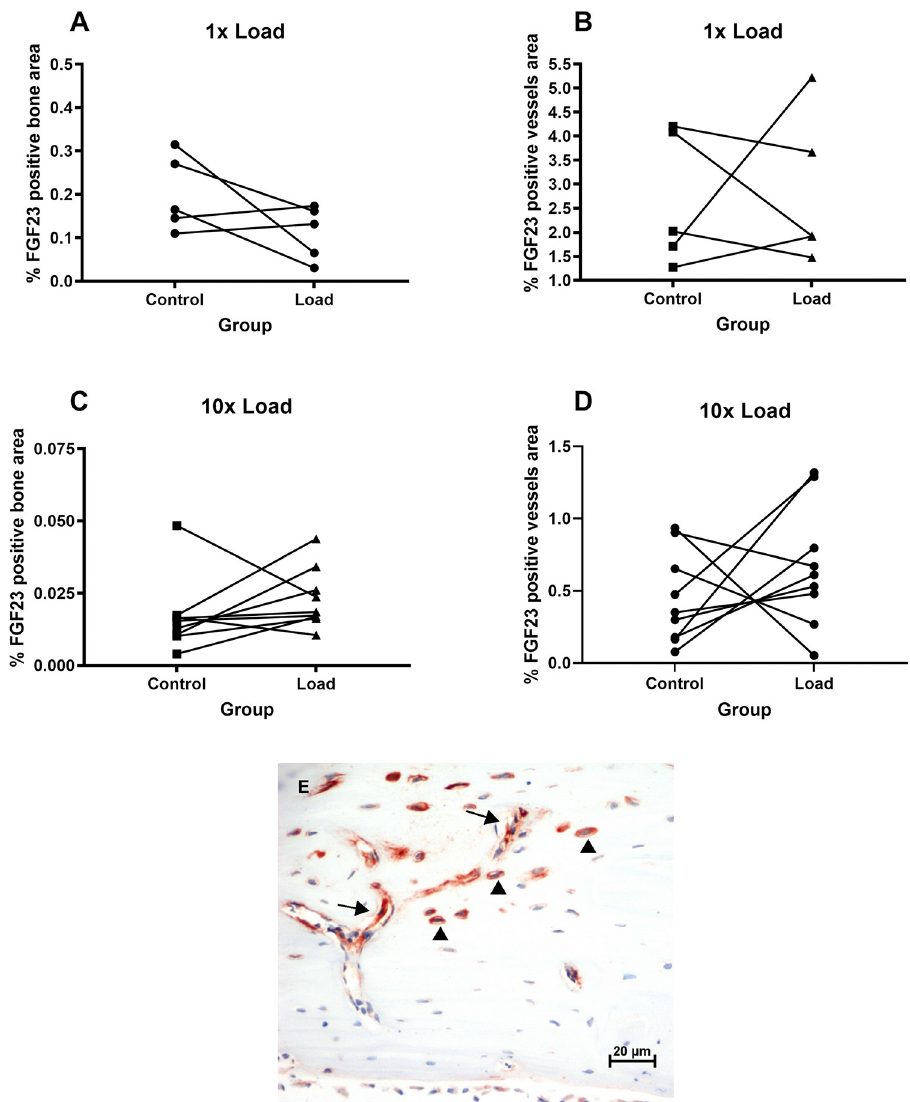
Fig 2. (A-E): Quantitative analysis of immunohistochemistry. Rats received a single bout of mechanical loading of the right tibia (A and B) or repeated loading of the right tibia (C and D). Paraffin sections of the tibiae were cut and stained for FGF23. The FGF23 positive area in as a percentage of the total bone area was measured in osteocytes (A and C) and in capillary blood vessels (B and D). (E) Representative image of FGF23 positive staining in osteocytes (arrowheads) and in capillary blood vessels